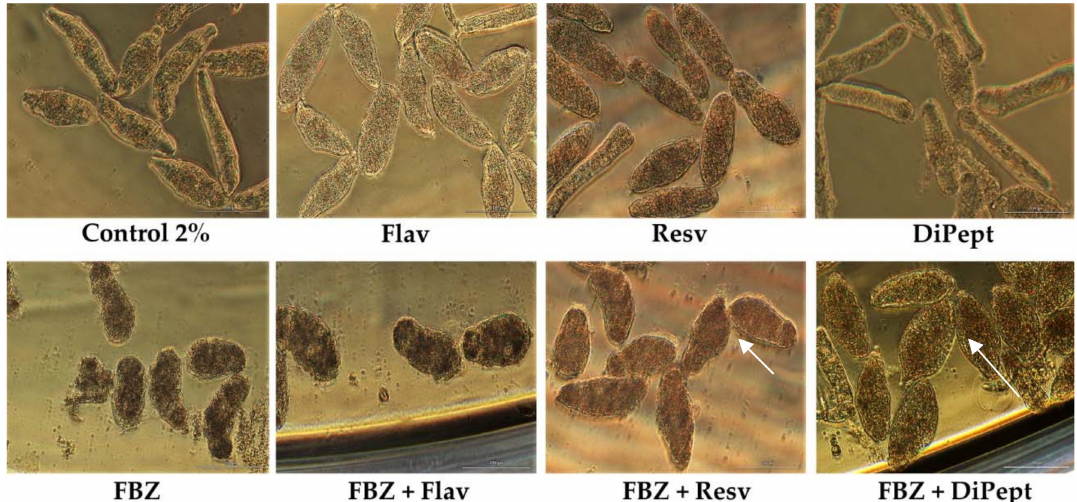
Figure 4. Representatives micrographs of NTS incubated with combinations of FBZ with Flav, Resv, and DiPept at 100 µ M and constant ratio 1:1 at 72 h post-exposure. Notably, the morphologic alterations in combinations were more similar to drug alone rather antioxidant, specifically FBZ + Flav. In combinations FBZ + Resv and FBZ + DiPept NTS were more swollen and altered in shape (white arrows). Scale bar, 100 µ m.